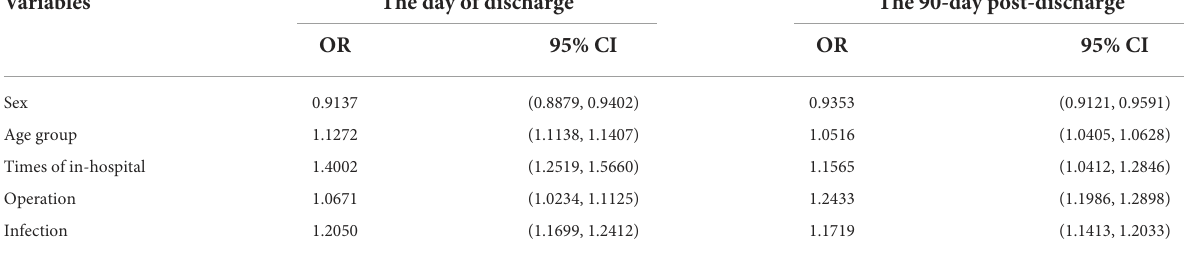
TABLE 5 The multivariate estimation of sex on the SICH